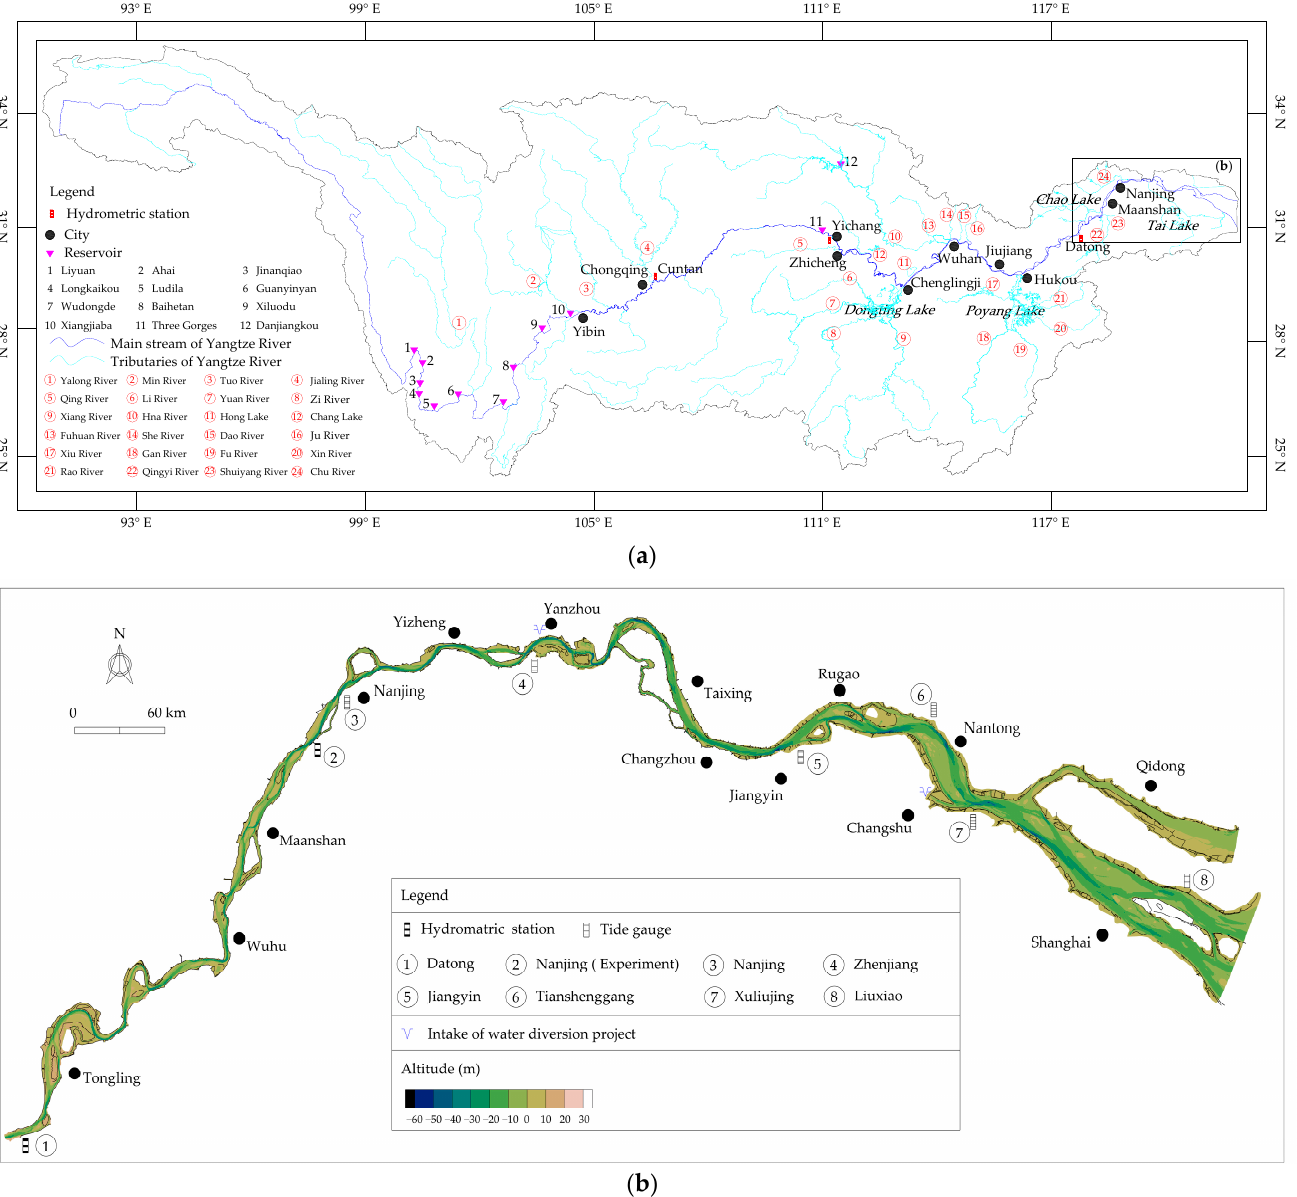
Figure 1. The geographical location and river regime of the study area: ( a ) the Yangtze River basin; ( b ) the study reaches from Datong to the estuary in the lower Yangtze River.